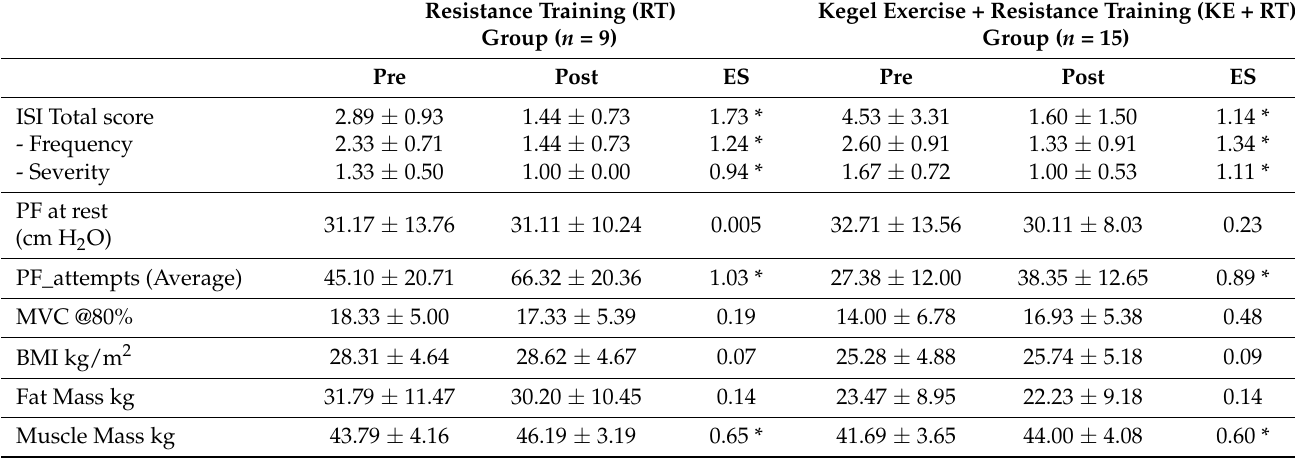
Table 2. Mean, standard error, and effect size of dependent variables in